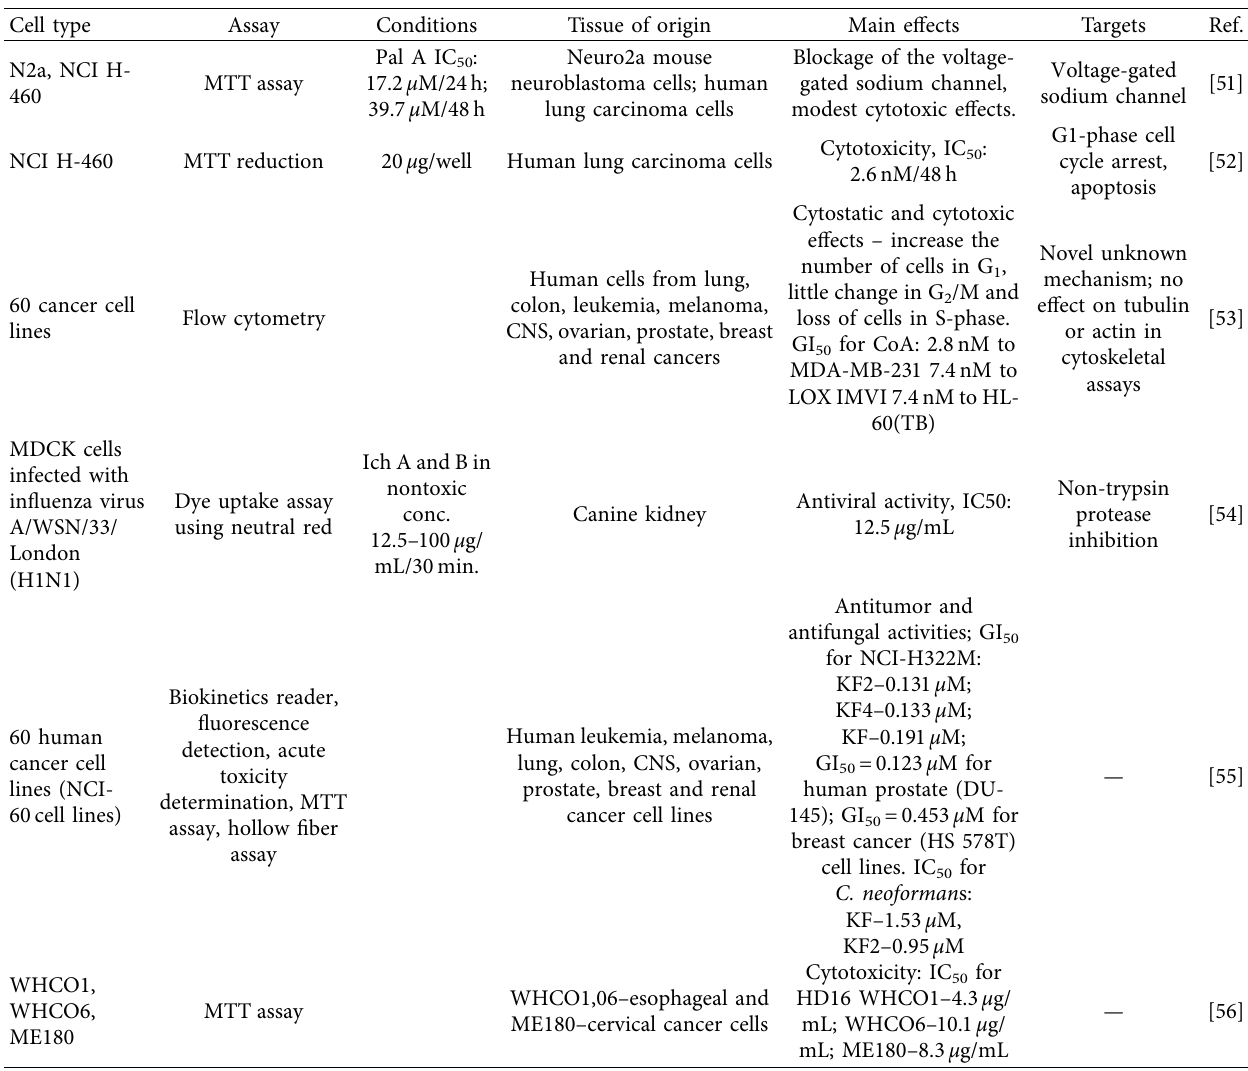
Table 5: Cytotoxicity of